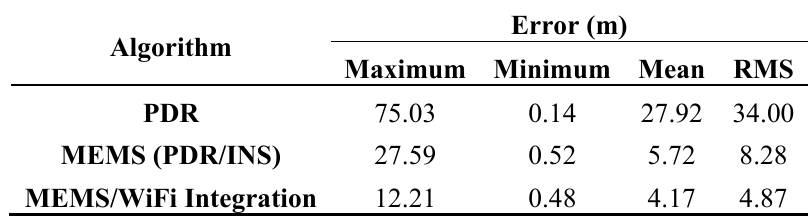
Figure 12. WiFi trajectory (Trajectory II). Table 2. Positioning performance of different algorithms in Trajectory